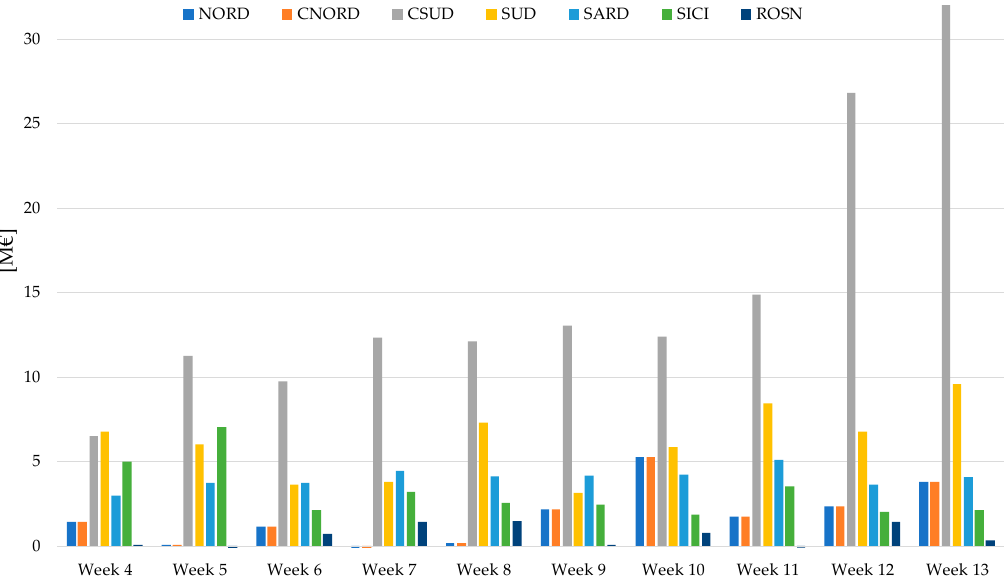
17 of 22 Figure 23. Weekly system costs paid by the Italian transmission system operator (TSO) for ancillary services. In particular, a considerable increment of approx. 100% of the costs is registered between week